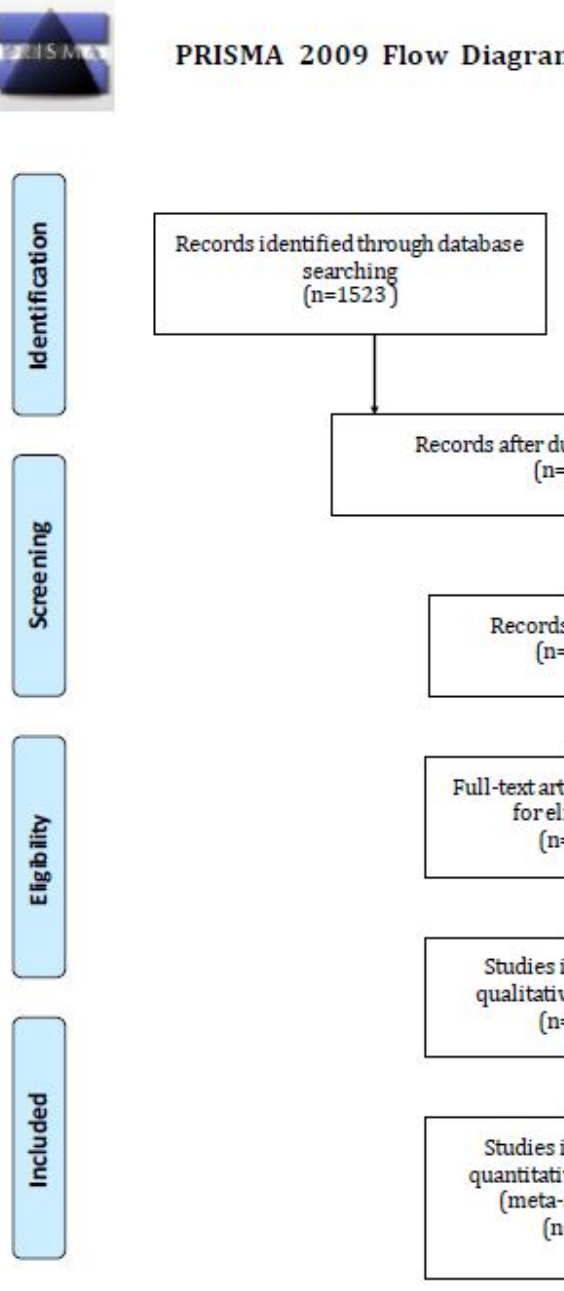
Figure 1. Flow chart of the study search and